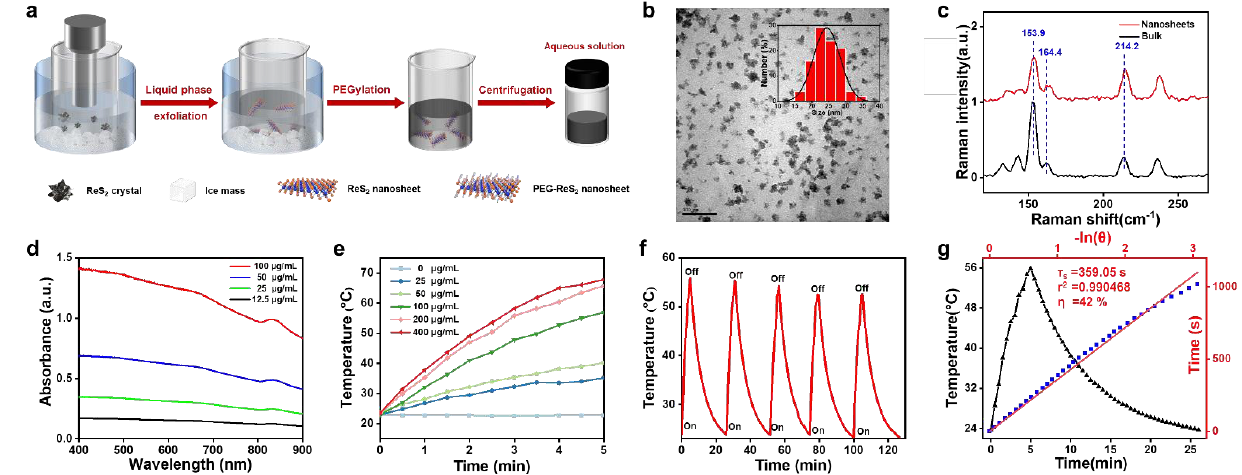
Figure 2. ( a ) Preparation strategy of PEG-ReS 2 nanosheets. ( b ) TEM image of PEG-ReS 2 nanosheets. ( c ) Raman spectrum of bulk ReS 2 and PEG-ReS 2 nanosheets. ( d ) Absorbance spectra of PEG-ReS 2 nanosheets at various concentrations (12.5, 25, 50, 100 μg/mL). ( e ) Photothermal heating curves of PEG − ReS 2 nanosheets in water at various concentrations (0, 25, 50, 100, 200, 400 μg/mL). The irradiation laser was 808 nm, with a power density of 1 W/cm 2 and an irradiation time of 5 min. ( f ) Photothermal heating and cooling curves of 100 μg/mL PEG -ReS 2 nanosheets in water were obtained from five laser on/off cycles. The irradiation laser was 808 nm, with a power density of 1 W/cm 2 . Within each heating-cooling cycle, the laser was turned on for 5 min. When the laser was turned off, the temperature of the PEG-ReS 2 nanosheets in water cooled down to room temperature before the laser was turned on again. ( g ) Plots of linear fitting cooling time versus negative natural logarithm of driving force temperature based on the heating and cooling curves in Figure 2f. The time constant (τ s ) of heat transfer is 359.05, and the PCE of PEG-ReSe 2 nanosheets can be calculated to be 42%.